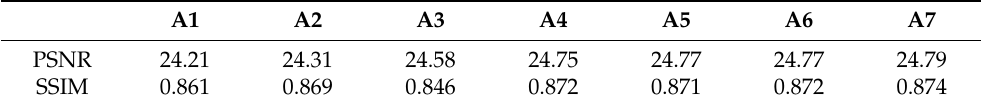
Table 1. Ablation studies on network structure and loss function. A1 represents the results of removing the CBAM model and A2 shows the predicted value of the last loop as the next input of the network. A3 is the case where MSEloss is used to measure the training effects of three loops. A4 represents the results of removing ConvLSTM. A5 and A6 are the results of adding three losses to the same loop for training and then performing one and three inferences. A7 is the overall network structure with progressive recurrent